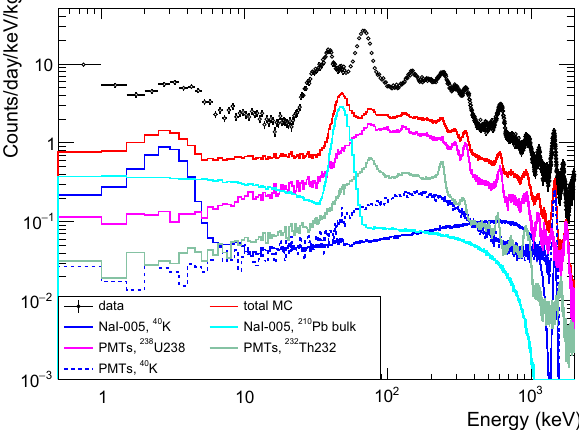
Fig. 2 Comparison of measured background spectra to spectra gener- ated by Monte Carlo simulation for single-hit events of NaI-005